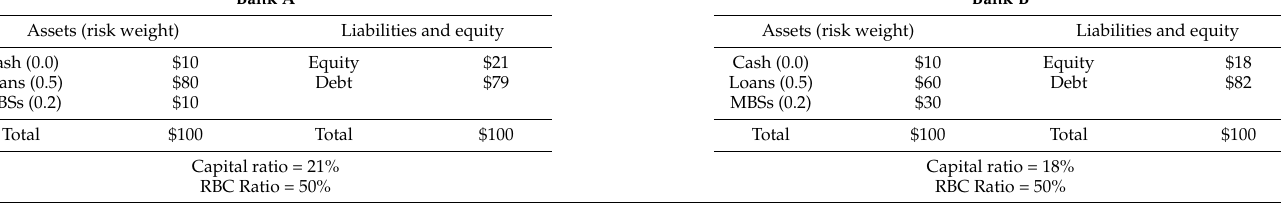
Table 1. Examples of capital and RBC ratios.